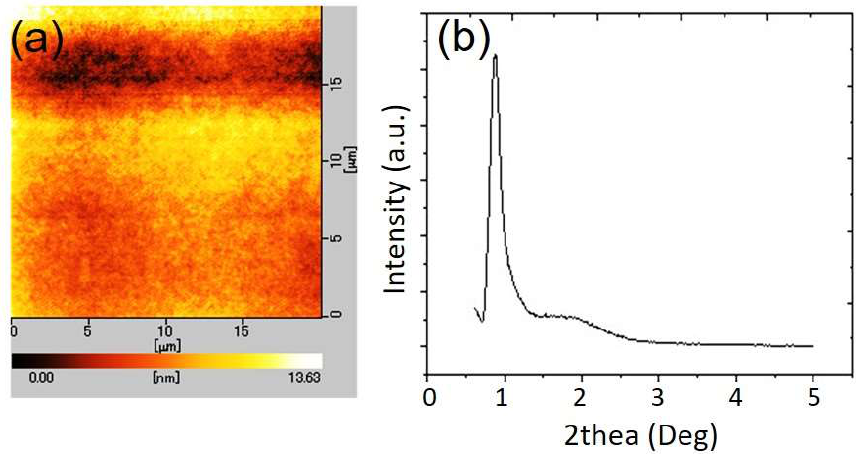
Figure 5. ( a ) Topological graph of the RNA–CTMA complex film obtained by atomic force microscopy (AFM). The root mean square (rms) surface roughness is measured to be 2.1 nm. ( b ) X-ray diffraction patterns of the RNA–CTMA complex.